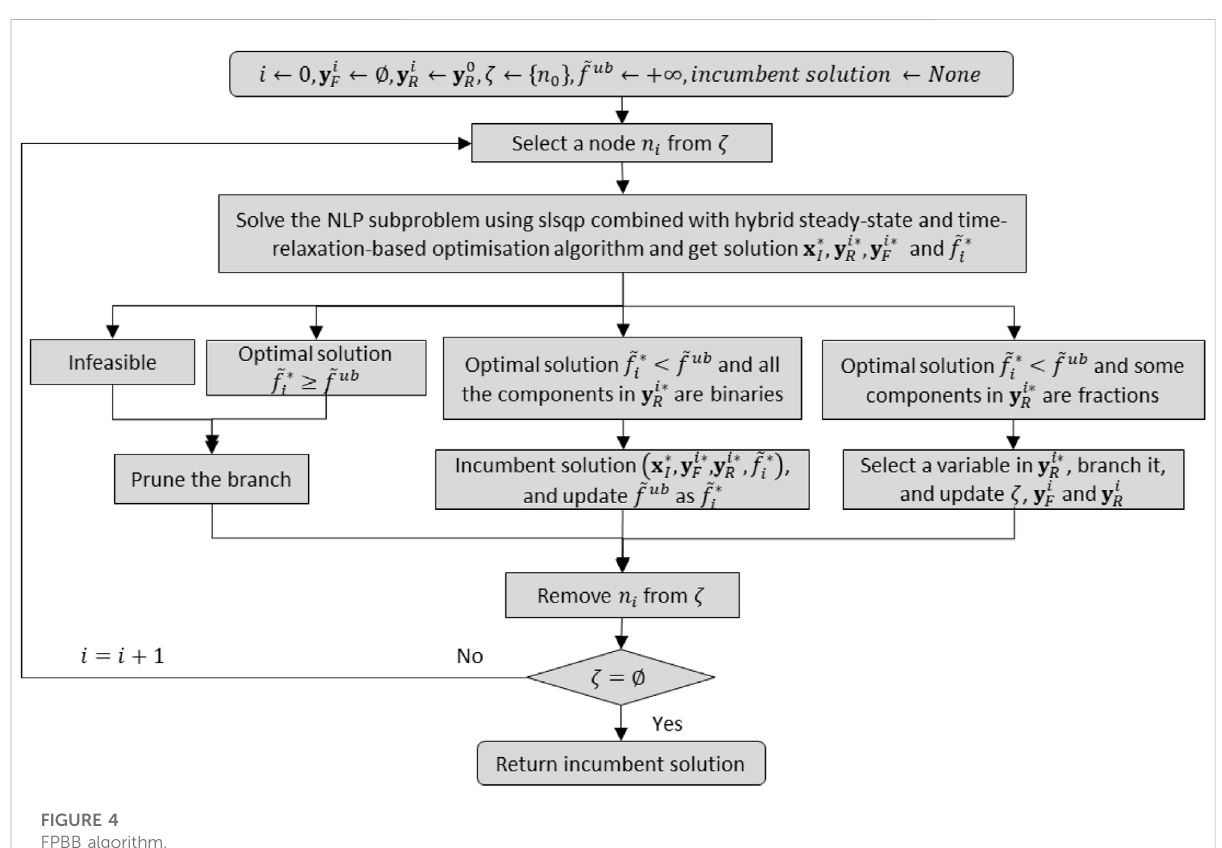
FIGURE 4 FPBB algorithm.